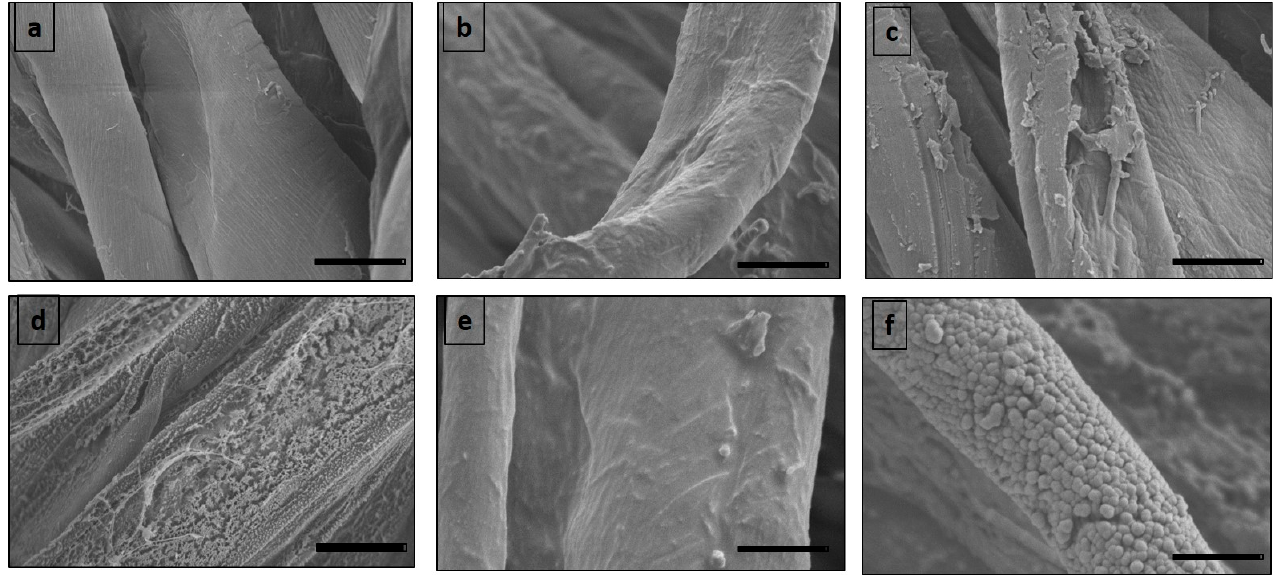
Figure 4. SEM images of ( a ) Pristine cotton, ( b ) Si-Cot_Dip, ( c ) Si-Cot_Plasma, ( d ) Cotton after oxygen plasma pre-treatment, ( e ) Si-Cot_Dip/O 2 , ( f ) Si-Cot_Plasma/O 2 (Scale bar: 10 μ m).